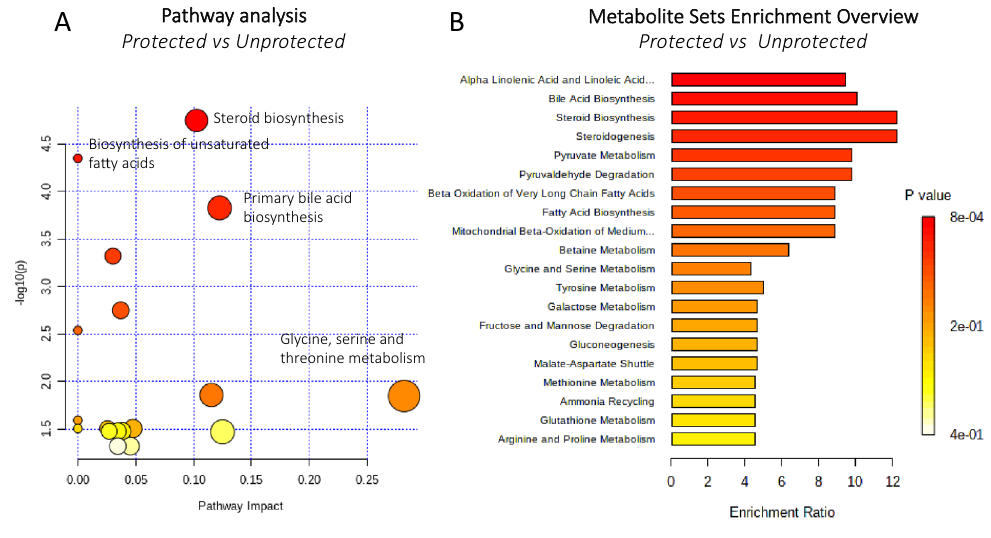
Figure 4. Pathways potentially involved in the protection from SARS-CoV-2. Metabolic pathway analysis performed on modulated metabolites ( A ) and metabolite sets enrichment ( B ). Steroid biosynthesis and biosynthesis of unsaturated fatty acids and amino acids may be involved in protection from COVID-19.